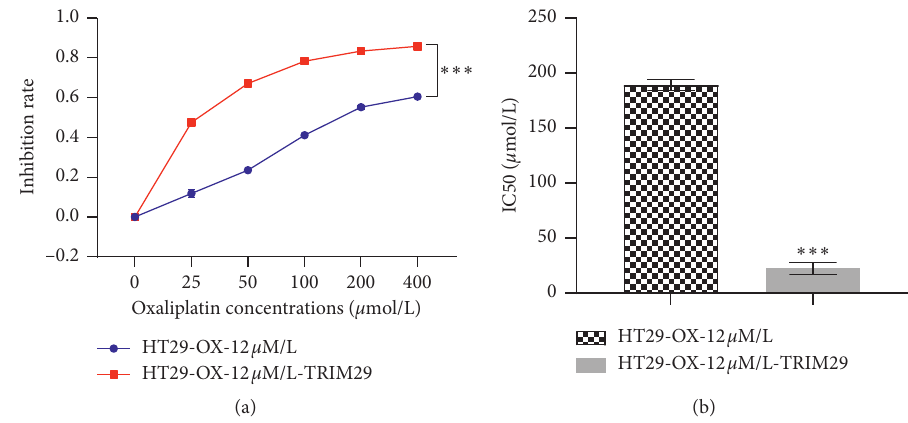
Figure 5: TRIM29 successfully reversed the resistance of the HT29-OX resistant cell model to oxaliplatin. (a) Inhibition curve in HT29- oxaliplatin-12 μ mol/L cells before and after transfection of pIRES2-ZsGreen1-TRIM29 plasmid. (b) Change of oxaliplatin IC50 in HT29- OX-12 μ mol/L cells before and after transfection of pIRES2-ZsGreen1-TRIM29 plasmid. Compared with HT29-12 μ mol/L oxaliplatin group, ∗∗∗ P < 0 . 05. The unpaired t -test was used to analyze comparisons between two groups. Data among multiple groups in skew distribution were tested by the nonparametric Kruskal–Wallis H